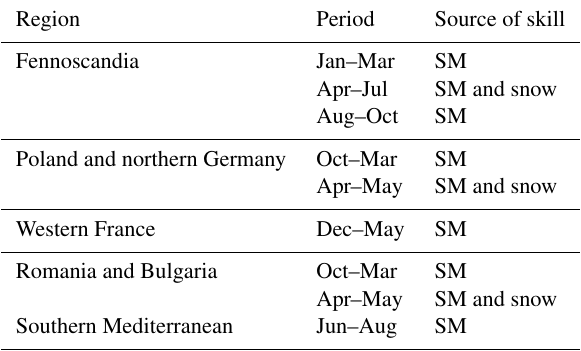
Table 1. Sources of skill for hotspot regions and periods of skill. SM is soil